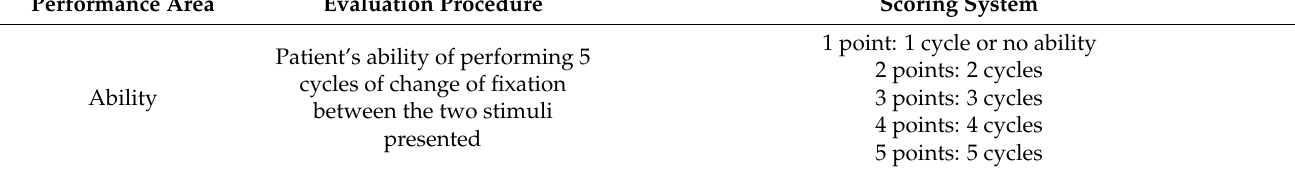
Table 1. Scoring procedure used in the NSUCO test for the evaluation of the oculomotor function. Performance